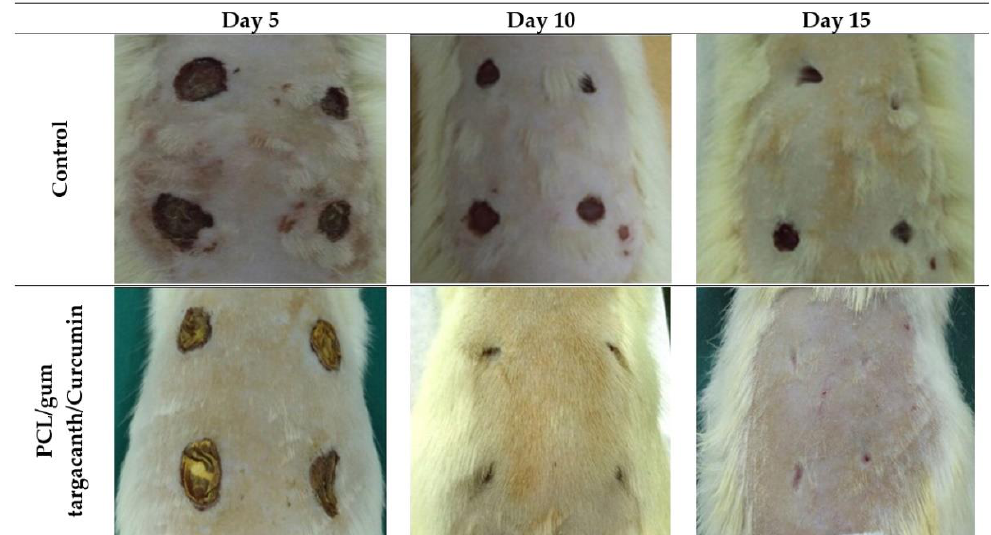
Figure 6. Evidence of accelerated wound closure in diabetic rat models (in vivo testing) promoted by curcumin-loaded biotextiles (adapted with permission from [230]).